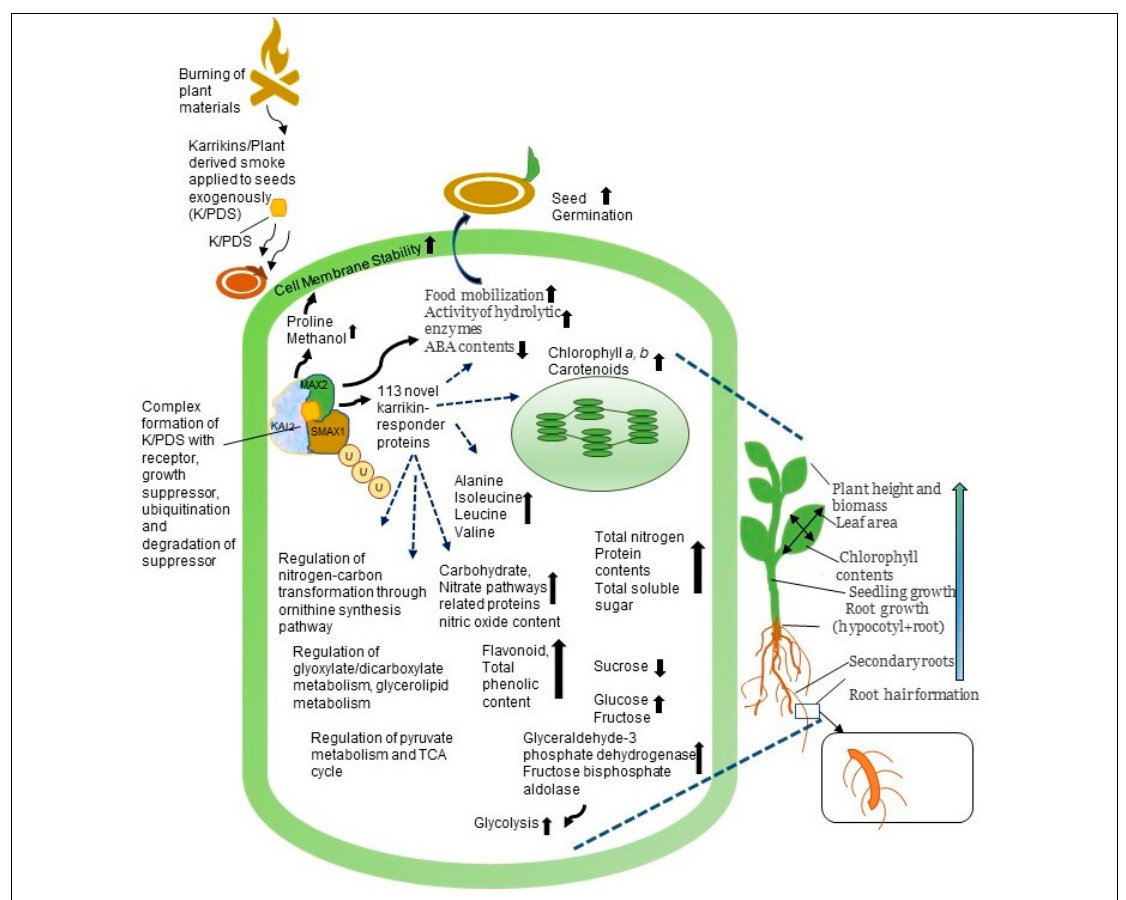
Figure 3. Schematic diagram showing diverse cellular responses to plant-derived smoke. Plant-derived smoke triggers regulation of various metabolic processes resulting in acceleration of seed germination and other growth processes. Upward and downward arrows indicate increased and decreased metabolic processes in response to plant-derived smoke, respectively. The dashed lines represent the possible relationship between smoke induced changes at molecular level and their effects. Abbreviations are as follows: K/PDS, karrikins/plant-derived smoke; KAI2, α / β hydrolases receptors of karrikins; MAX2, F-box subunit of a SCF class of E3 ubiquitin-protein ligase complex; SMAX1, a growth suppressor protein; and TCA, carboxylic acid cycle.